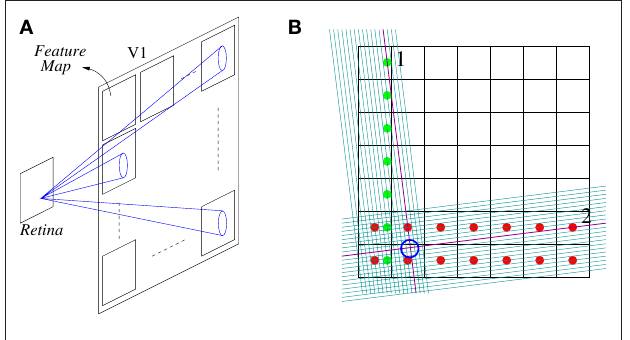
Figure 21 | (A) Projection Field Topology of V1 layer in Visual Cortex. (B) Hybrid CMOS-memristor arrangement with CMOL style tilted lines.